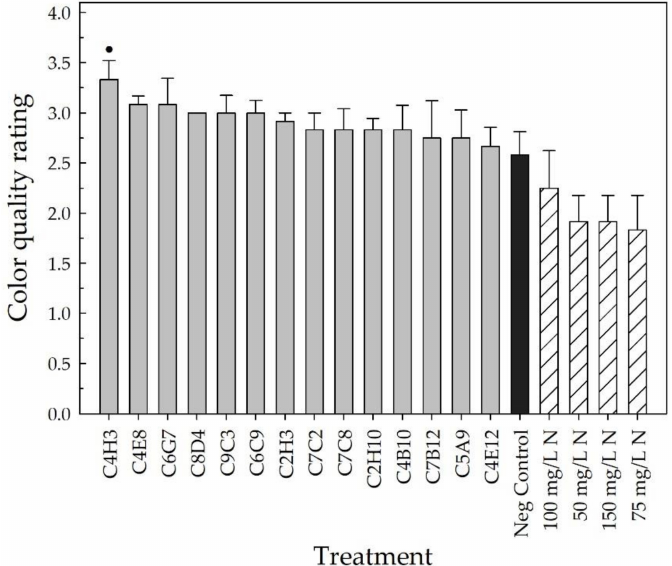
Figure 9. The color quality rating, which measured the visual color quality of the vegetation in the greenhouse validation trial, was evaluated at harvest of Petunia × hybrida ‘Picobella Blue’ treated with the 14 bacterial strains selected from the high-throughput greenhouse trials ( n = 12). The rating scale ranged from 1 (interveinal chlorosis on five or more leaves) to 4 (good green vegetation with no discoloration). All plants receiving bacterial treatments were fertilized with 25 mg L − 1 N (gray bars). The black bar represents the negative control (no bacterial treatment) fertilized with 25 mg L − 1 N, and the white bars with slanted lines represent the four positive controls (no bacterial treatment) fertilized with either 50, 75, 100, or 150 mg L − 1 N. The color quality rating was analyzed using the Kruskal–Wallis rank sum test, followed by Dunn’s test of multiple comparisons with FSA. ( • ) shows differences in color quality rating compared to the negative control at p ≤ 0.1. Bars represent the mean, and error bars denote standard